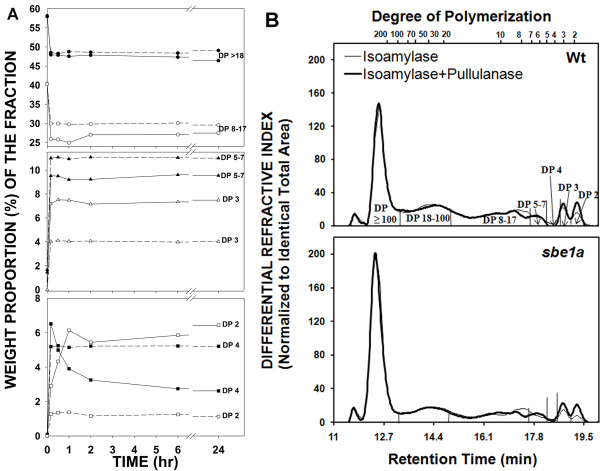
Amylopectin and amylose structure of Wt and sbe1a mutant starch samples by HPSEC analysis. A. Proportions of chains1 from debranched2 β-dextrins during time course of β-amylolysis of amylopectin from Wt (----) and sbe1a mutant (- - -) starch using β-amylase (250 U/mL). B. Chromatograms1 of isoamylase-debranched and isoamylase-plus-pullulanase-debranched β-limit dextrins3 from amylose fraction from Wt and sbe1a mutant starch. 1Chromatographic regions were divided as in [40]. Proportions of DP ≥ 18, DP 8-17, DP 5-7, DP 4, DP 3 and DP 2 were calculated as the areas for DP ≥ 17.5, 7.5 ≤ DP ≤ 17.5, 4.5 ≤ DP ≤ 7.5, 3.5 ≤ DP ≤ 4.5, 2.5 ≤ DP ≤ 3.5, and DP ≤ 2.5, respectively, as in [40]. Proportions of chains in each region for B are presented in Additional File 4. Calculation was based on representative chromatograms for starch from one biological replication. Values are percentage by weight. 2Debranching was performed successively with isoamylase for 24 h and pullulanase for 24 h. 3β-Limit dextrin was obtained after 3 times of 24-h β-amylolysis on amylose.